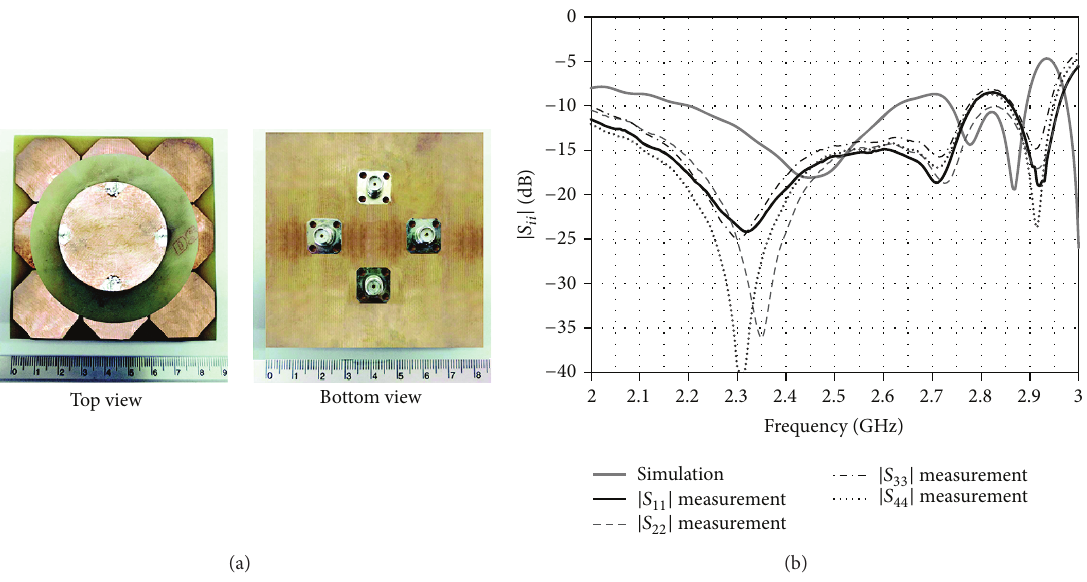
Figure 9: (a) Photograph of the antenna prototype. (b) The 𝑆 parameters as a function of